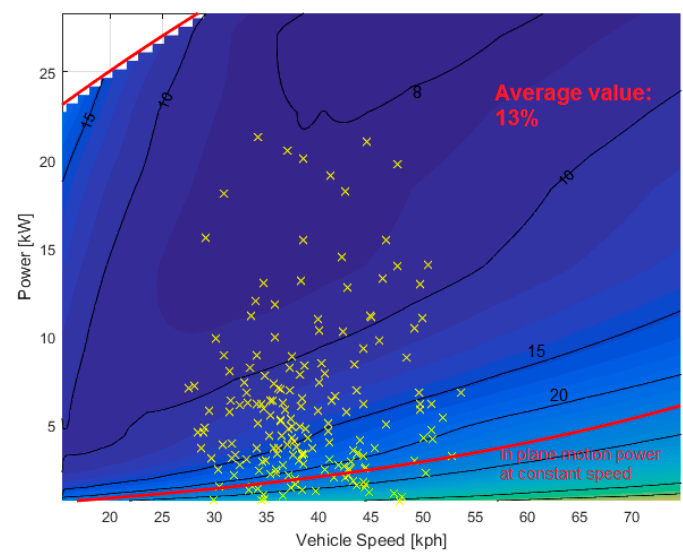
Figure 13. Urban mission work points on the electrical-loss (%) contour map. Energies 2017 , 10 , 2142